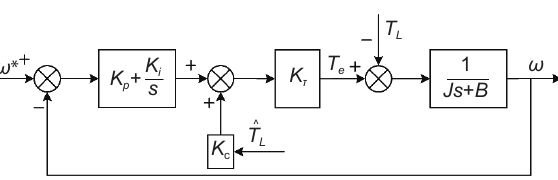
Fig. 8 Block diagram of speed loop control with feed- forward compensation.